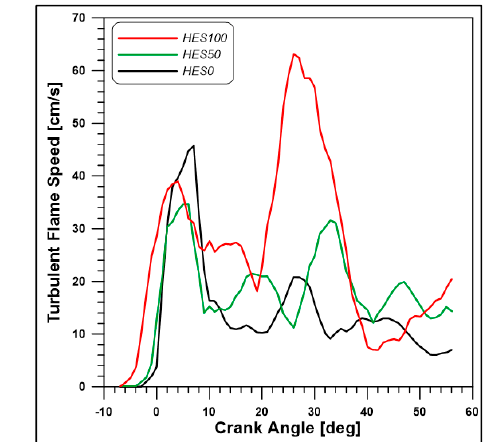
Figure 26. Laminar and turbulent flame speeds .